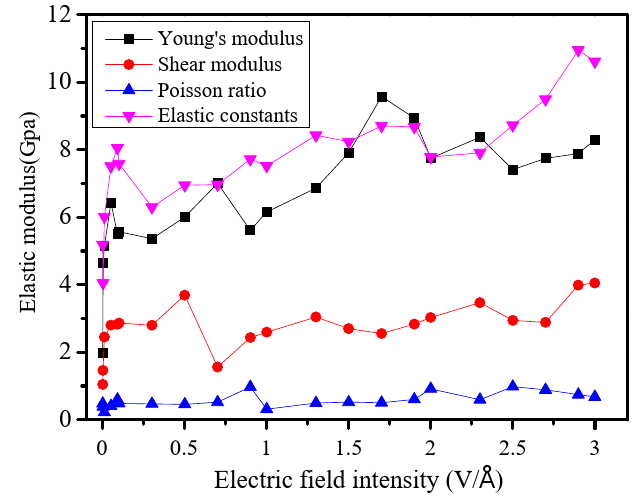
Figure 10. Changes of elastic modulus.